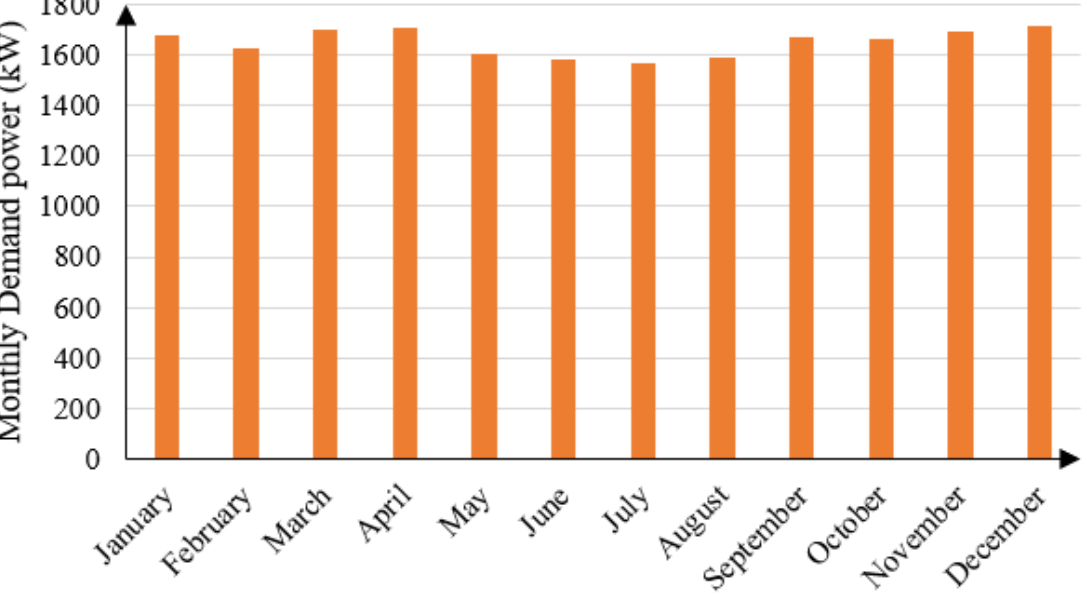
Figure 7. The monthly maximum power of class-A customer in Ontario. Table 3. Comparison results of the existing battery energy storage system (BESS) sizing for demand charges (DC) [15] and the proposed method.